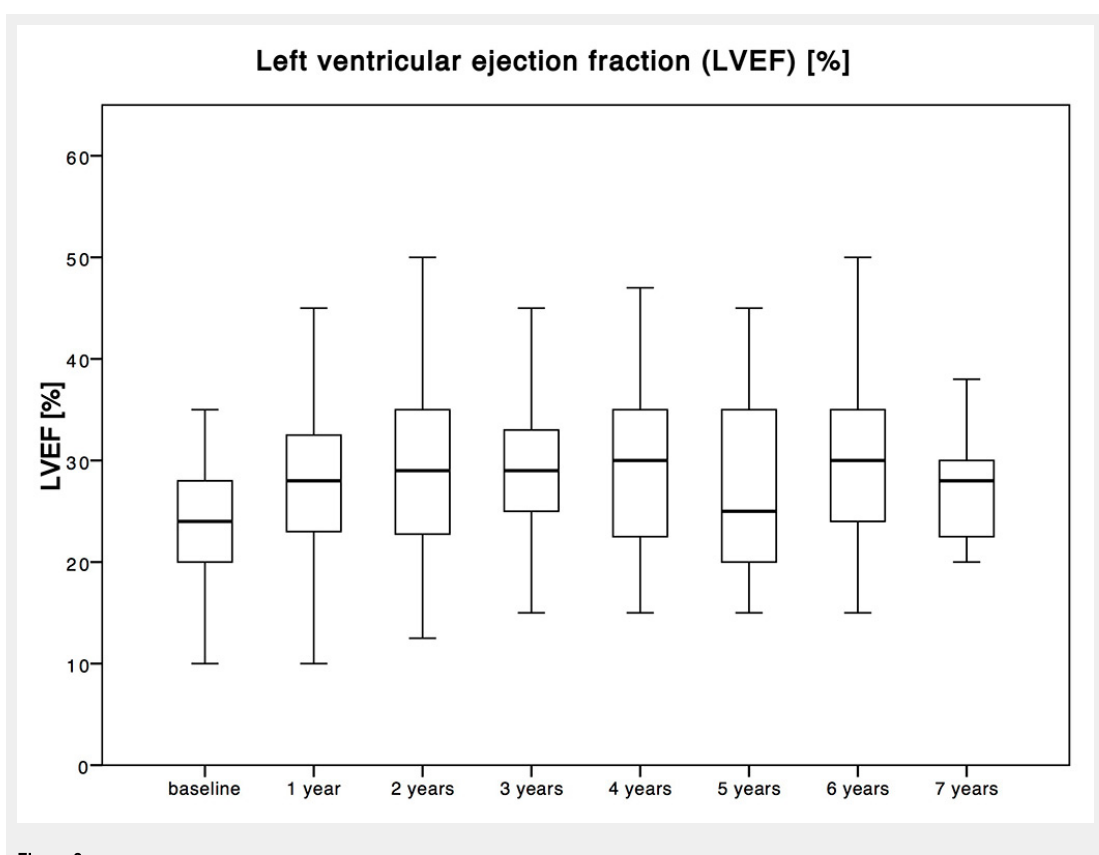
Figure 3 Changes in ejection fraction during long-term follow-up in patients without improvement to >40% (boxes indicate the interquartile range, whiskers 1.5-fold the length of the